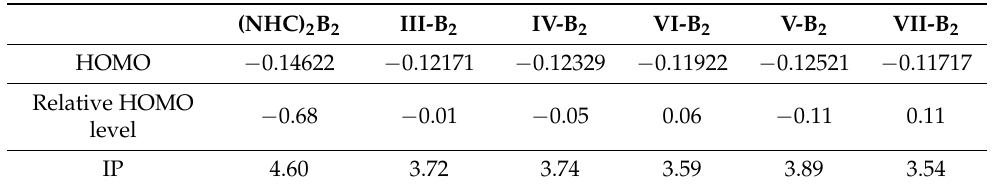
Table 3. The HOMO level (in Hartree), relative HOMO level (in eV), and IP (in eV) of diboryne adducts III-B 2 –VII-B 2 estimated on an M06-2X/cc-pVDZ theory